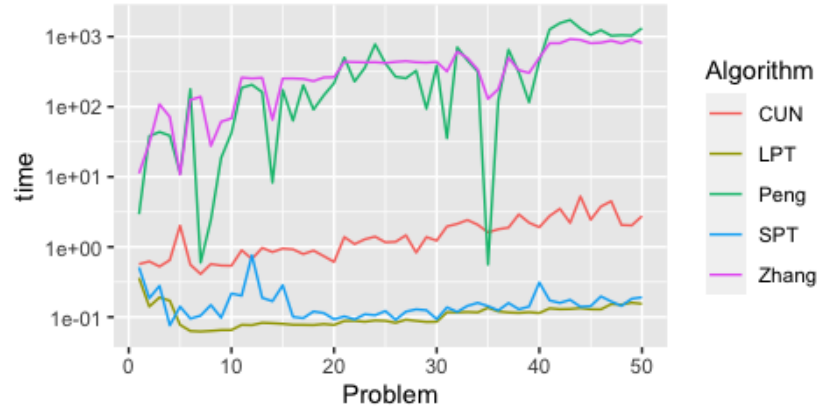
Figure 5. Runtime, in seconds (scientific notation), for each problem (TAI1-TAI50).